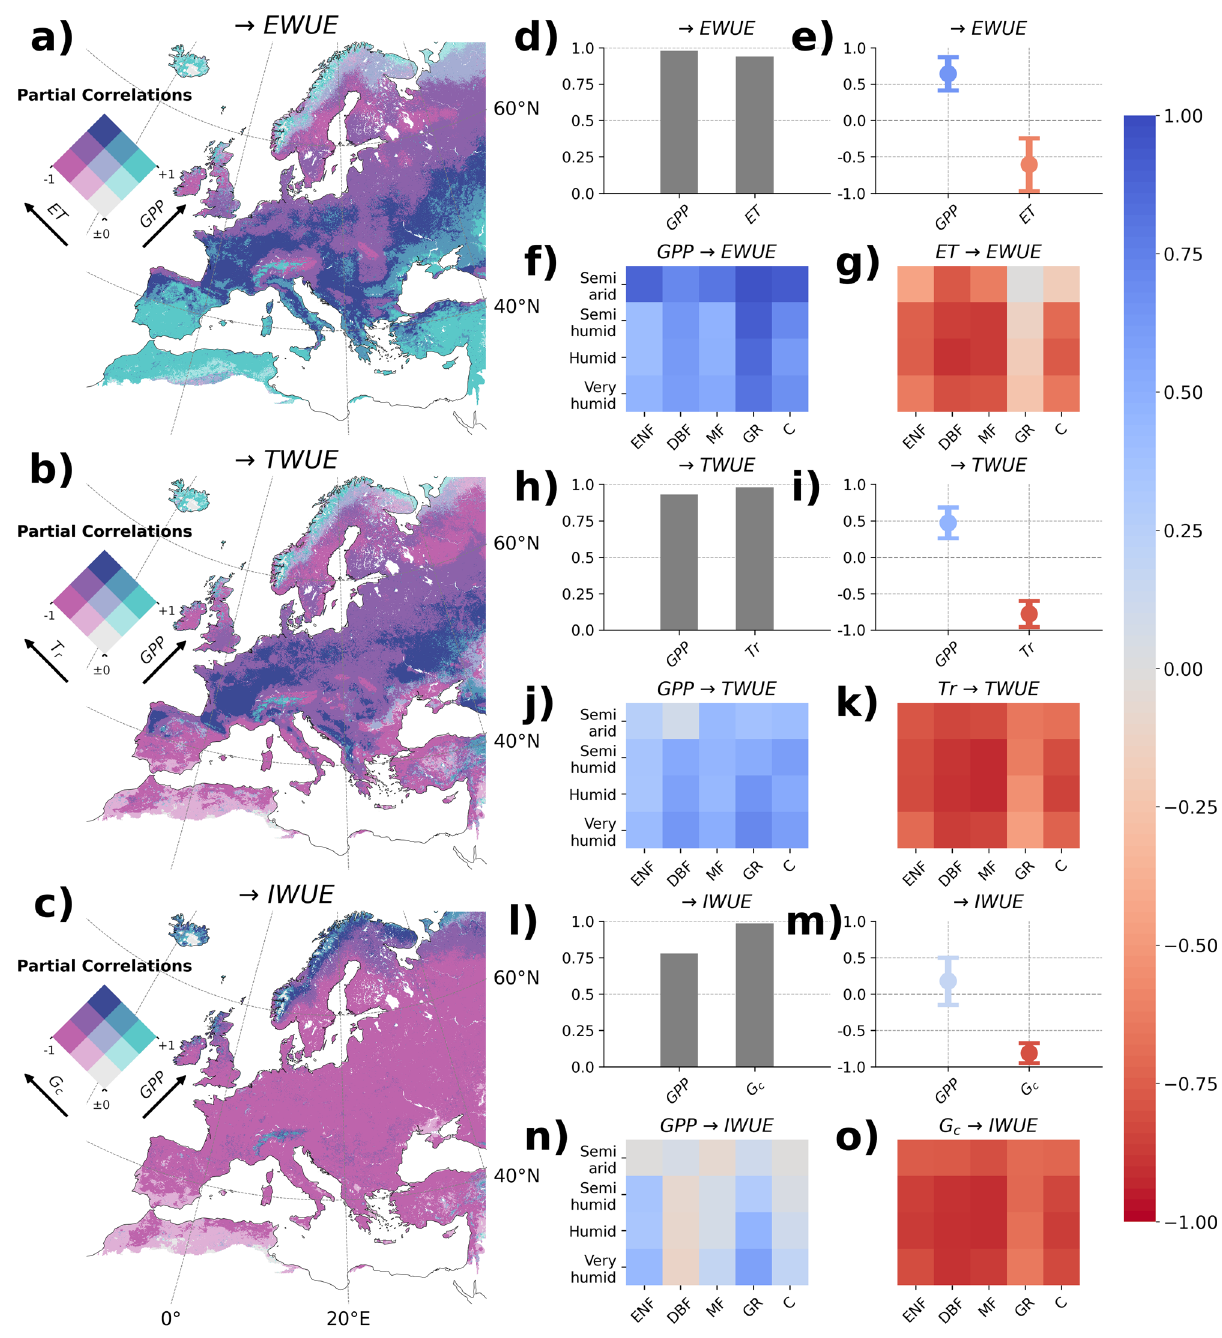
Fig. 4 EWUE change is caused by gross primary production (GPP) on the Iberian Peninsula and evapotranspiration (ET) variability in Central and Eastern Europe, while we determined less directed causal links to TWUE and IWUE. Here we show partial correlations of GPP versus ET to EWUE ( a ), GPP versus transpiration (T r ) to TWUE ( b ) and GPP versus canopy conductance (G c ) to IWUE ( c ) from the PCMCI + analysis. Green colors show a stronger link between GPP and WUE variability, and pink colors a stronger link between water-use and WUE, while gray shows low correlations and dark purple strong correlations of both. On the right side, we show for each map the relative area to the total land surface where PCMCI + yielded directed links from GPP and water-use WUE ( d , h , l ) and the respective mean partial correlations (circle) across the continent with the standard deviation (error range marker) ( e , i , m ). Lastly, we aggregate the partial correlations of those links ( f , g , j , k , n , o ) over land cover (x-axes, ENF Evergreen Needleleaf Forest, DBF Deciduous Broadleaf Forest, MF Mixed Forest, GR Grasslands, C Croplands) and hydro-climates absolute difference of the corresponding values between the maps of GPP and ET links in Supplementary Fig. S8a, b and c as drought and the non-drought PCMCI + analyses, to highlight the we did in Fig. 4a, b, and c. For the bars of relative area covered by aggregated response of the links to droughts (see Methods for a signi fi cant links (Supplementary Fig. S8d, h and l), the mean link more detailed description). strengths (Supplementary Fig. S8e, i and m) and the aggregations The number of grid cells and therefore the relative area with of mean link strengths across hydro-climate and land cover signi fi cant links between GPP, water-use or G c have generally (Supplementary Fig. S8f, g, j, k, n and o), we rather show the